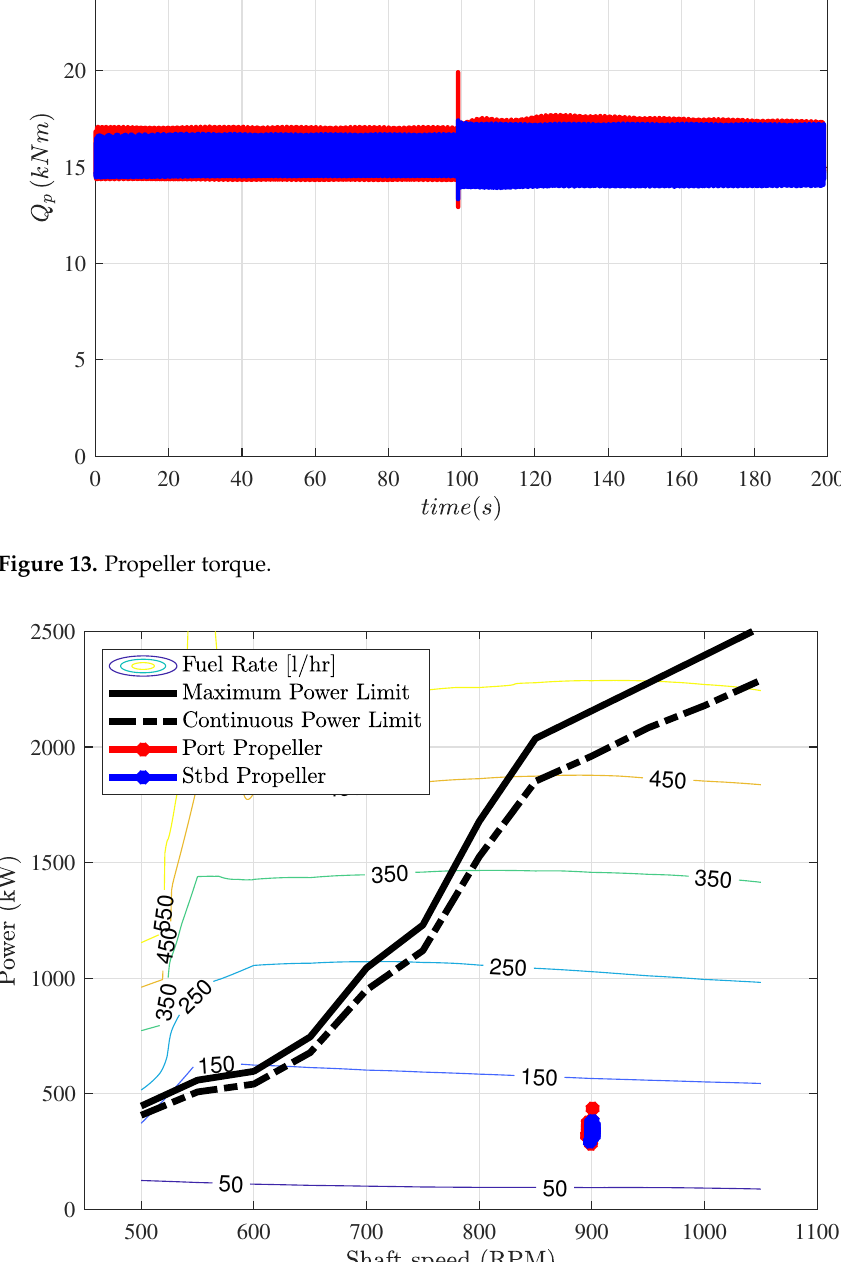
Figure 14. Propeller required power on the engine load